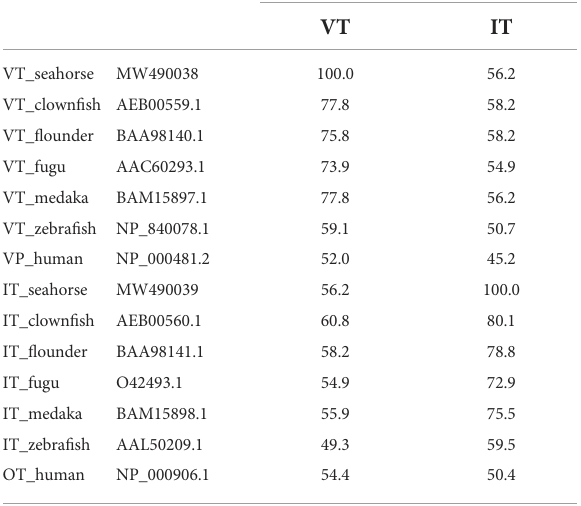
TABLE 2 Similarities of amino acid sequences of the neurohypophysial hormone between the lined seahorse and other teleosts.